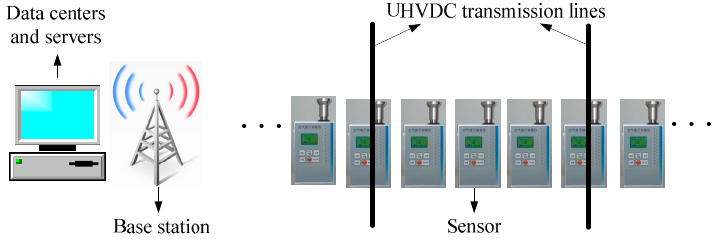
Figure 16. Arrangement diagram of measurement system.